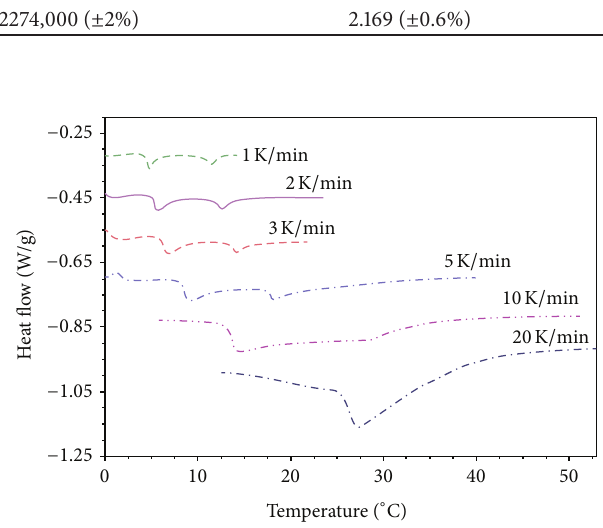
Figure1:DSCthermogramsofPNIPA-SA/water(20%/80%)system in equilibrium swelling degree. Heating was performed with 1, 2, 3, 5, 10, and 20K/min after cooling with 10K/min.